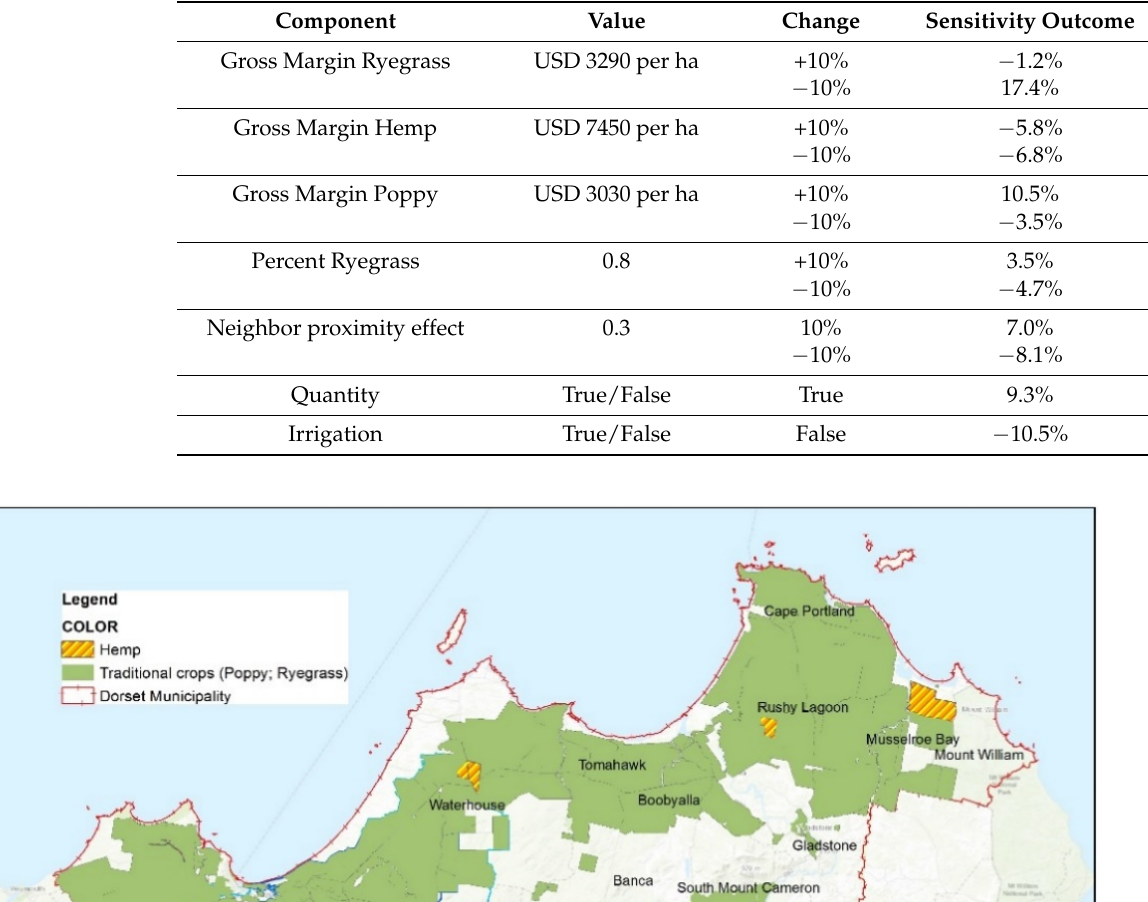
Table 1. Sensitivity of key model parameters relative to baseline values.